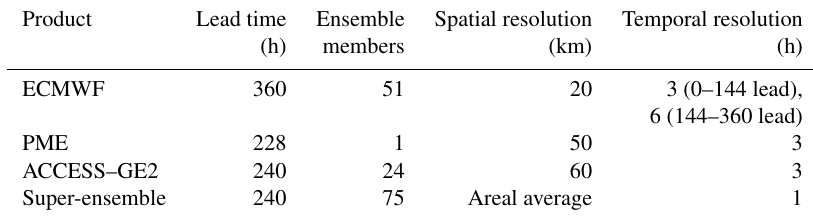
Table 1. Raw rainfall forecast products. Product Lead time Ensemble Spatial resolution Temporal